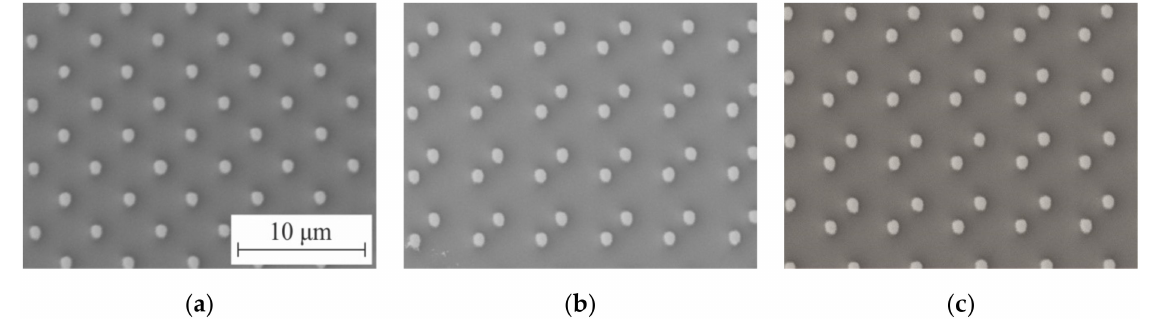
Figure 15. SEM microimages of 2D DSE structures written on the CLWS300IAE: test structure with shift of 2.5 µ m ( a ); with shift of 1.8 µ m ( b ); with shift of 1.6 µ m ( c ).